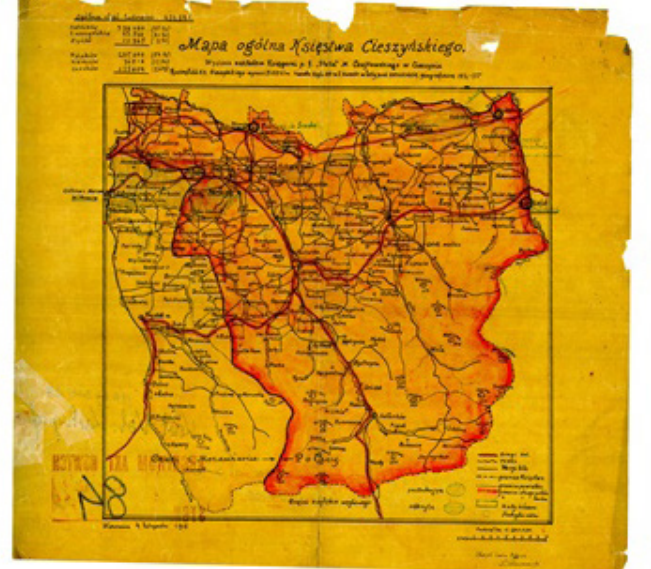
Fig. 5. General map of the Duchy of Cieszyn, 1:200,000, Cieszyn 1918 (source: Archive of New Files, group 260, reference number